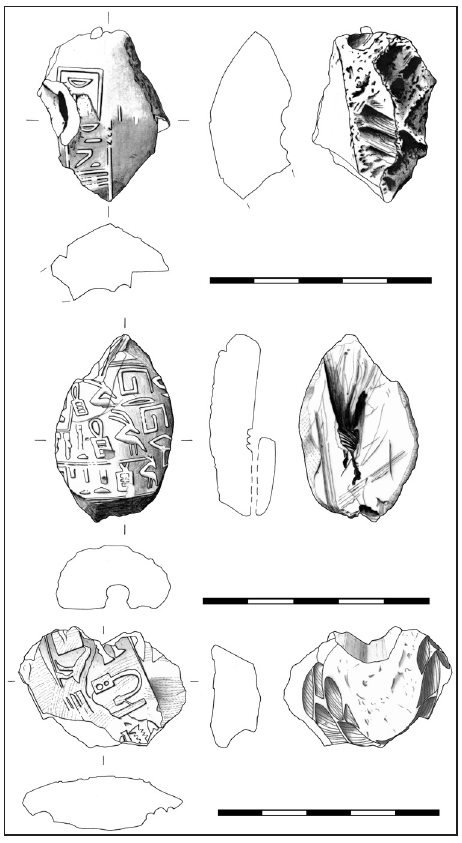
Fig. 4: Seal impressions from Hierakonpo- lis, today in the Museum of Archaeology and Anthropology, University